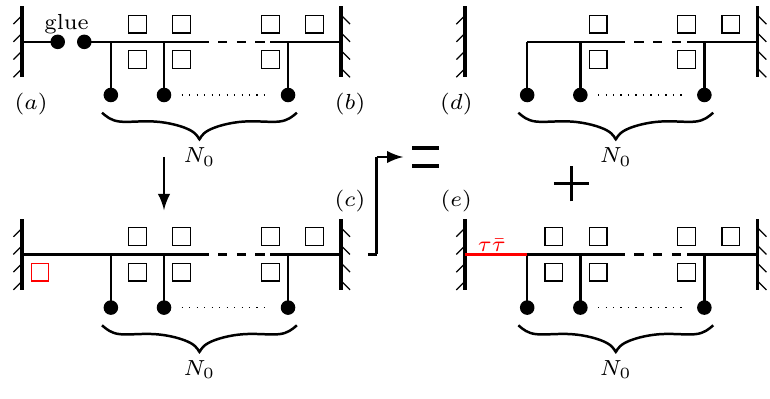
Figure 10 . (Color online.) The basis of N 0 (cid:28) (cid:22) (cid:28) ’s on a cylinder (c) obtained from gluing the basis of a single (cid:28) (cid:22) (cid:28) on a disk (a) to a basis of N 0 + 1 (cid:28) (cid:22) (cid:28) ’s on a disk (b) by annihilating a pair of (cid:28) (cid:22) (cid:28) ’s. The basis (c) is equivalent to the sum of the bases (d) and (e), which are in fact a basis of N 0 (cid:28) (cid:22) (cid:28) ’s and that of N 0 + 1 (cid:28) (cid:22) (cid:28) ’s on a